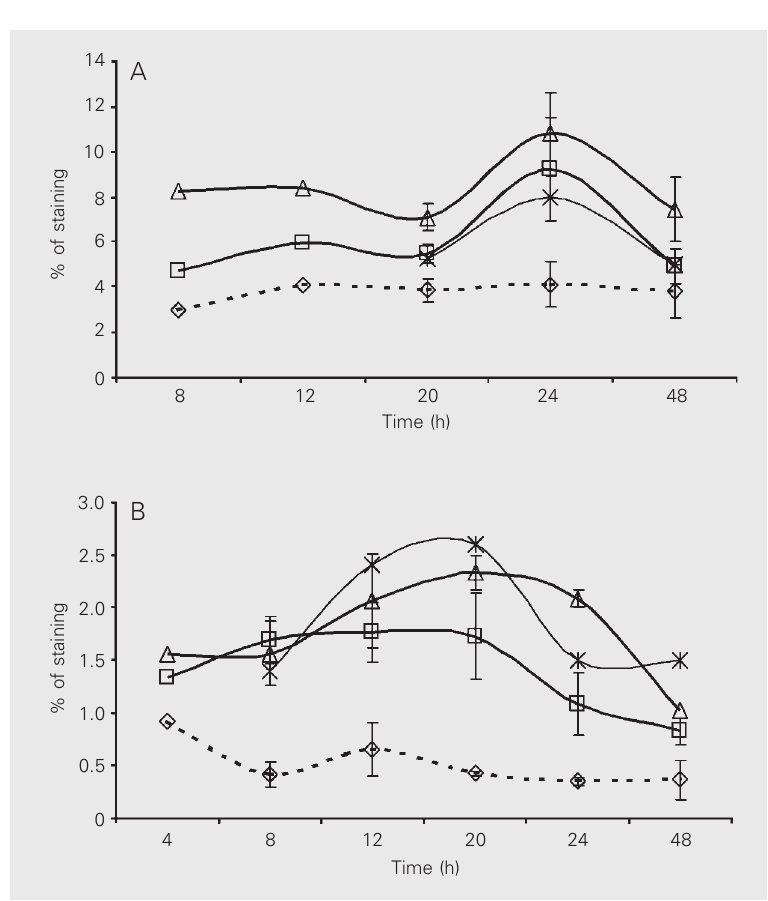
Figure 2. Kinetics of IL-4 (A) and IL-10 (B) production in total lymphocytes from phytohemagglutinin (PHA)-, purified protein derivative (PPD)- or Mycobacterium leprae -stimulated peripheral blood mononuclear cells of tuberculosis or leprosy patients, respectively. The dashed lines and diamonds indicate non-stimulated cultures (medium), the squares indicate PPD-stimu- lated cultures, the triangles indicate PHA-stimulated cultures, and the asterisks indicate M. leprae -stimu- lated cultures. Data are reported as means ± SEM (N = 3) obtained from antigens ( Mycobacterium anti- gens, 10 µg/ml, and 1% PHA) plus cells additionally stimulated with PMA, ionomycin and brefeldin